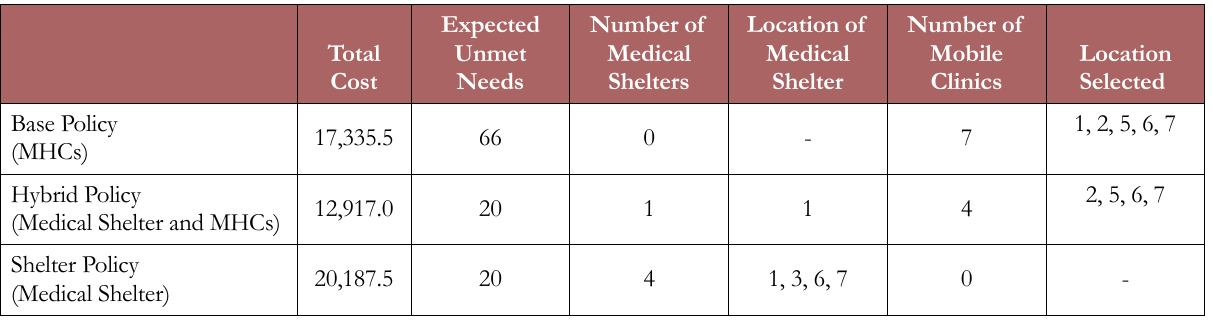
Table 4. Result comparison of base policy and hybrid